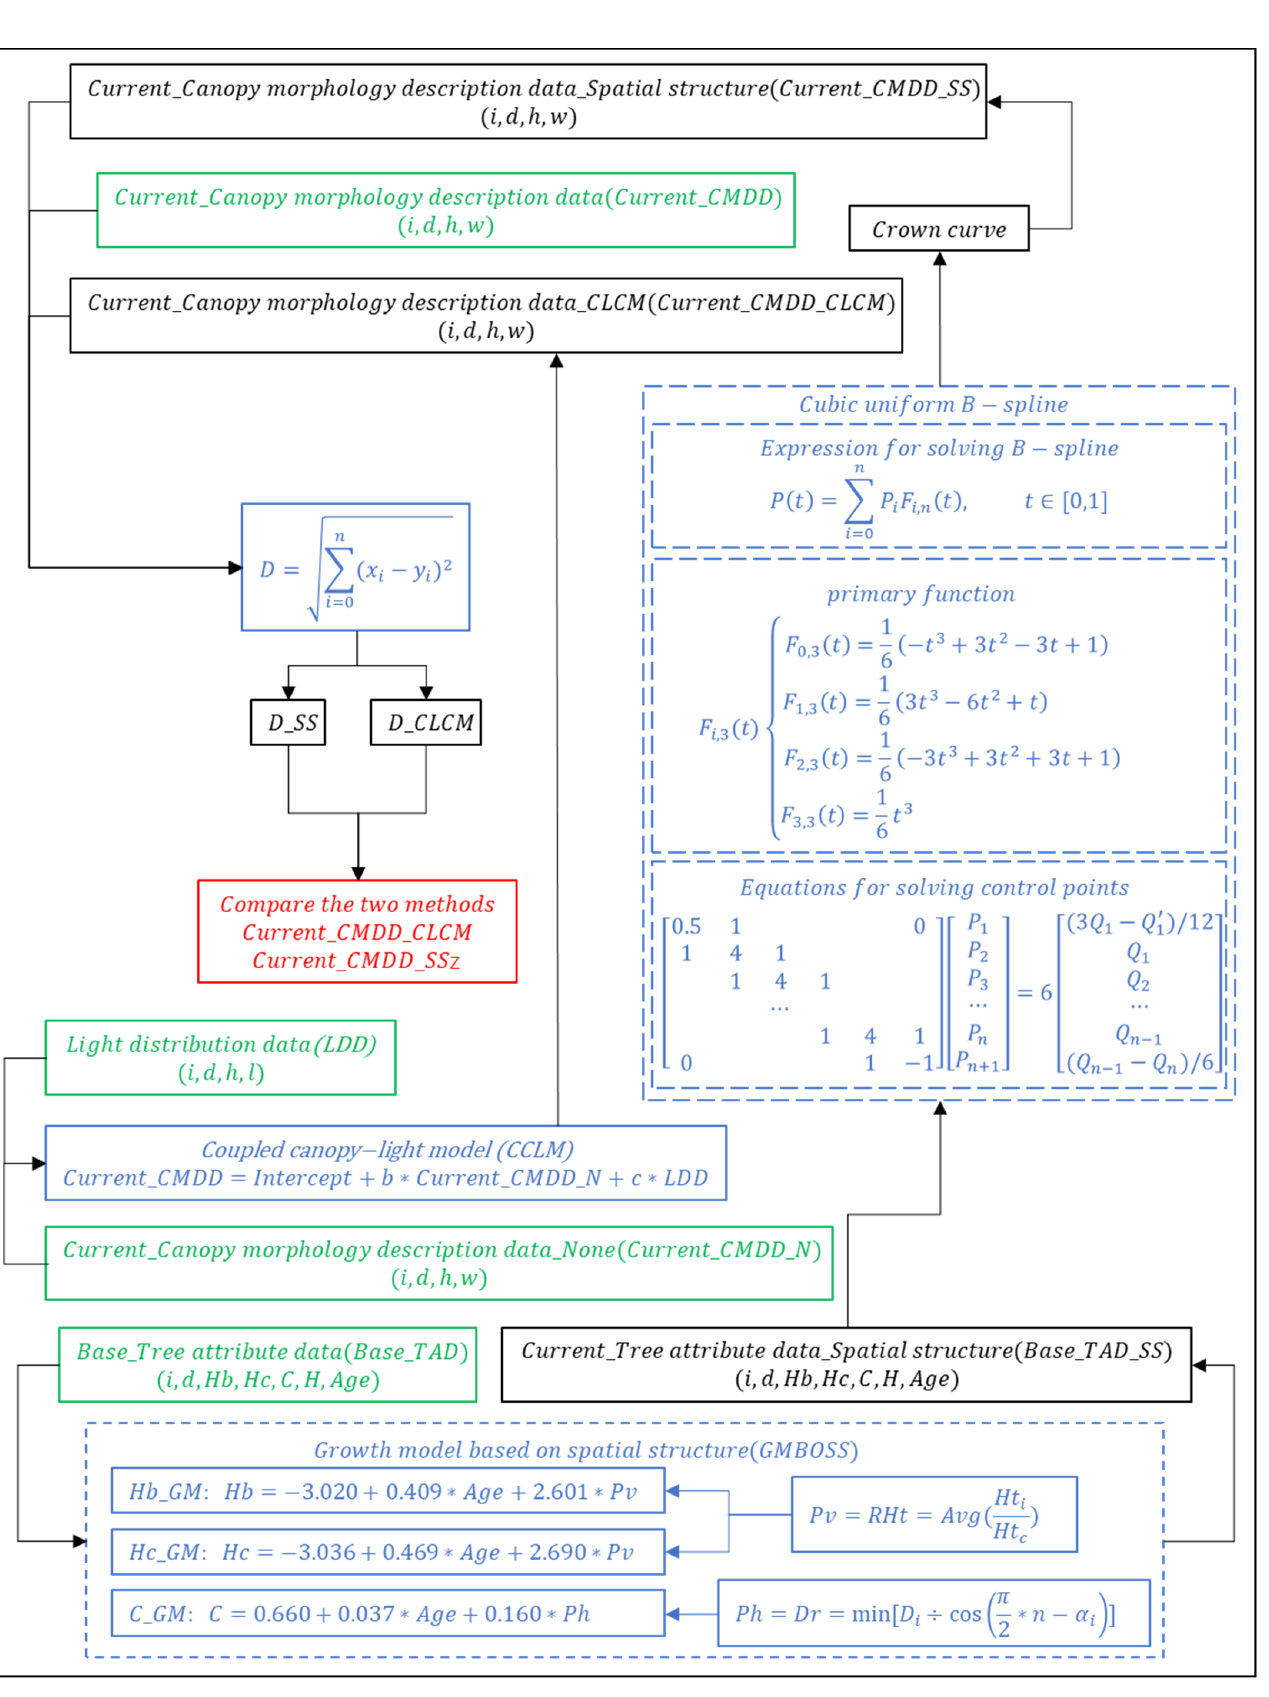
Figure 6. Contrast validation model.